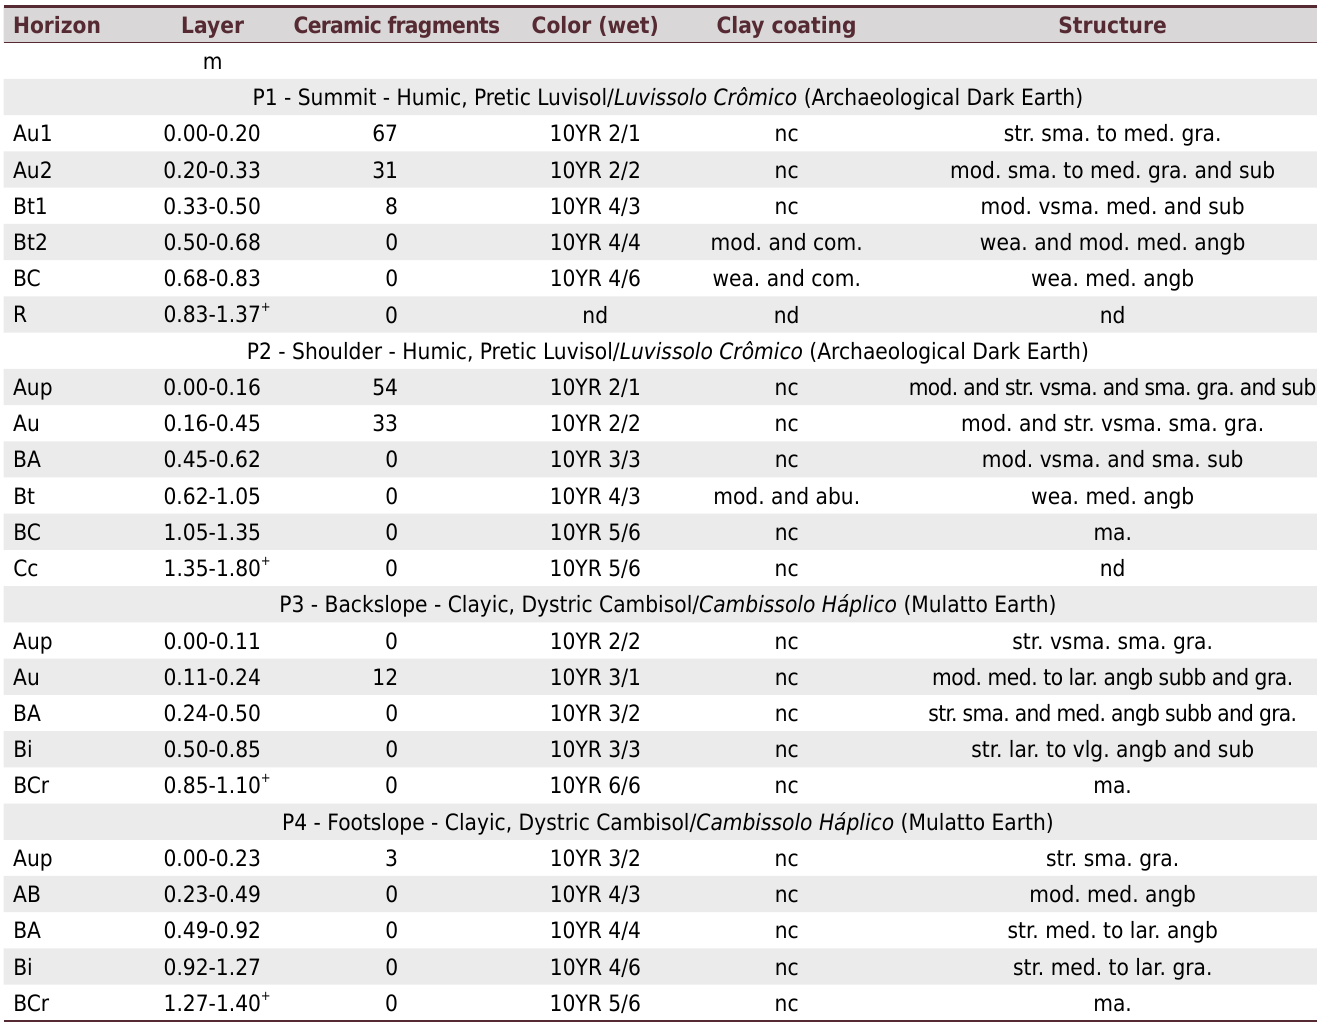
Table 1. Morphological properties of Archaeological Dark Earth and Mulatto Earth in western Amazonia, Brazil Horizon